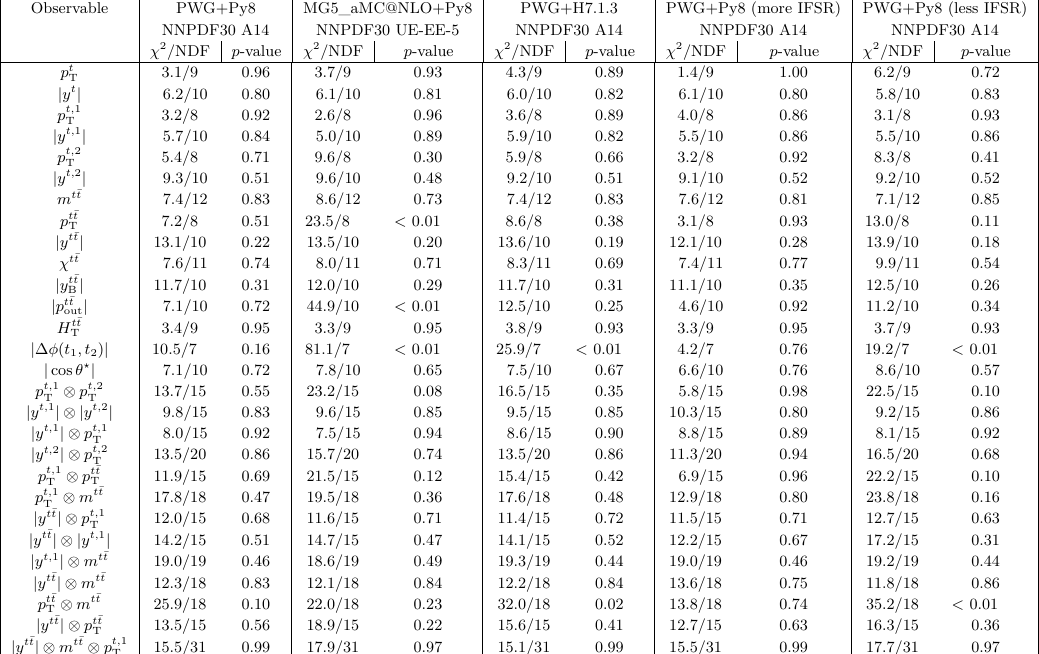
Comparison between the measured normalized parton-level differential cross-sections and the predictions from several MC event generators. For each observable and calculation, a χ 2 and a p -value are calculated using the covariance matrix described in the text, which includes all sources of uncertainty in the measurement. The uncertainty in the calculation is not included. The number of degrees of freedom (NDF) is equal to N b − 1 , where N b is the number of bins in the